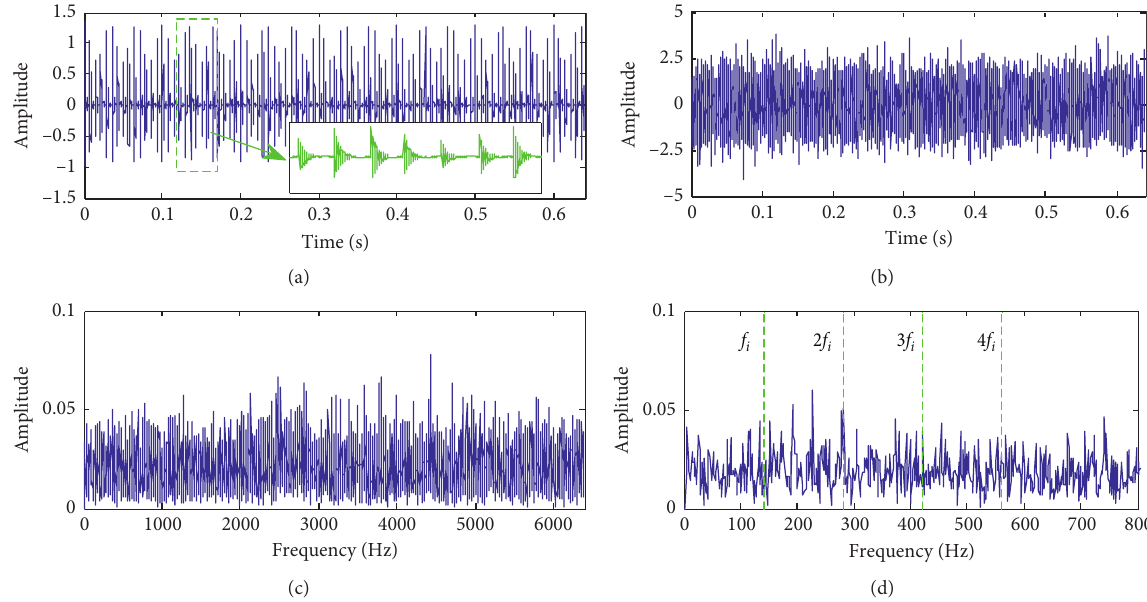
Figure 6: (a) The waveform of periodic impacts. (b) The waveform of simulated fault signal. (c) The frequency spectrum of simulated fault signal. (d) The envelope spectrum of simulated fault